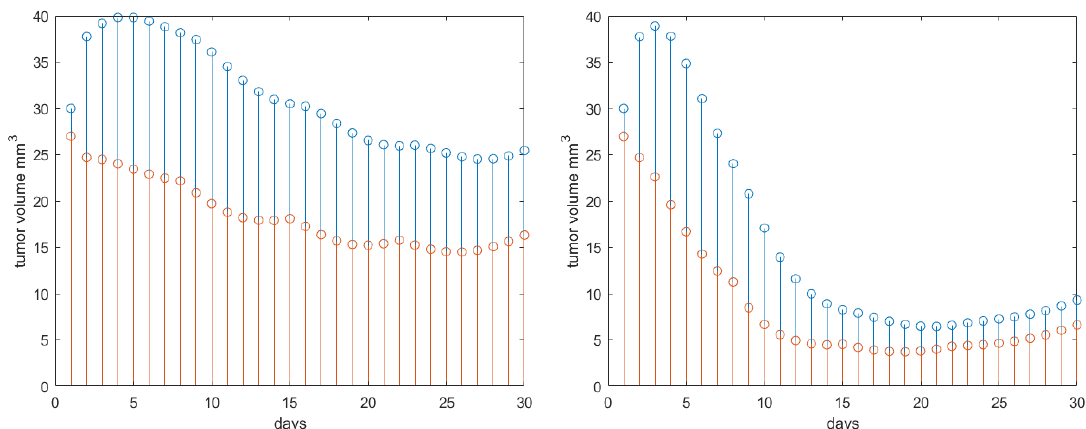
Figure 7. Results obtained for Protocol 3 in tumor growth volume with synergy degree varying from 1 ( left ) to 8 ( right ). Red stems denote the active tumor volume and blue stems the total tumor volume.